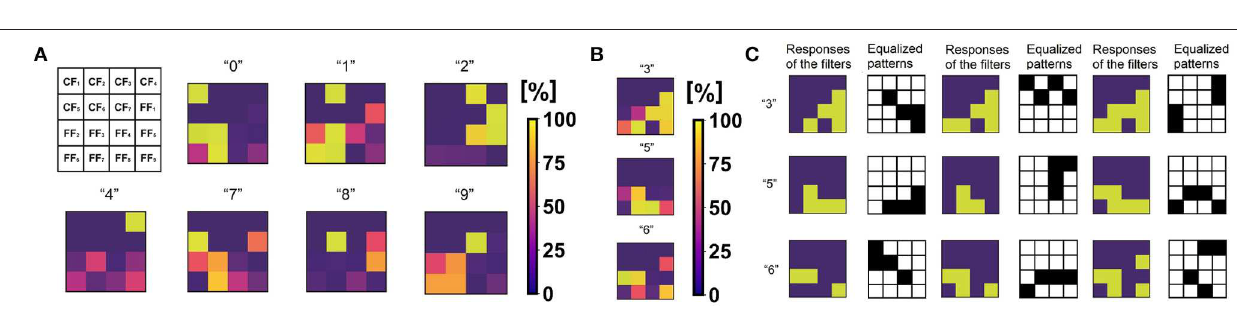
FIGURE 4 | (A) Average feature maps for the trained classes 0, 1, 2, 4, 7, 8, and 9. (B) Average feature maps for the non-trained classes 3, 5, and 6. (C) Extraction for the study of the three most probable feature maps for each one of the non-trained classes. Each one of these feature maps has a different equalized pattern. The neural redundancy allows to assign an equalized pattern to each feature map in order to improve the classification accuracy of the WTA